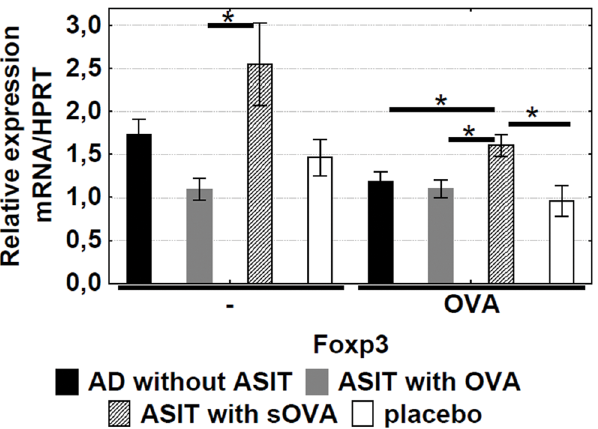
Fig 5. Level of Foxp3 expression. The specific mRNAs in OVA-stimulated mice splenocytes (incubated with OVA for 72hrs) were quantified by qRT-PCR. The results are presented as mean mRNA expression (mean ± SE, n = 8 for each). The relative levels of Foxp3 expression were calculated by referring to the HPRT (hypoxanthine guanine phosphoribosyltransferase) in each sample. AD without ASIT: OVA-sensitized untreated mice; ASIT with OVA: OVA-sensitized mice treated by ASIT with OVA; ASIT with sOVA: OVA- sensitized mice treated by ASIT with sOVA; placebo: PBS-sensitized mice. * , p <